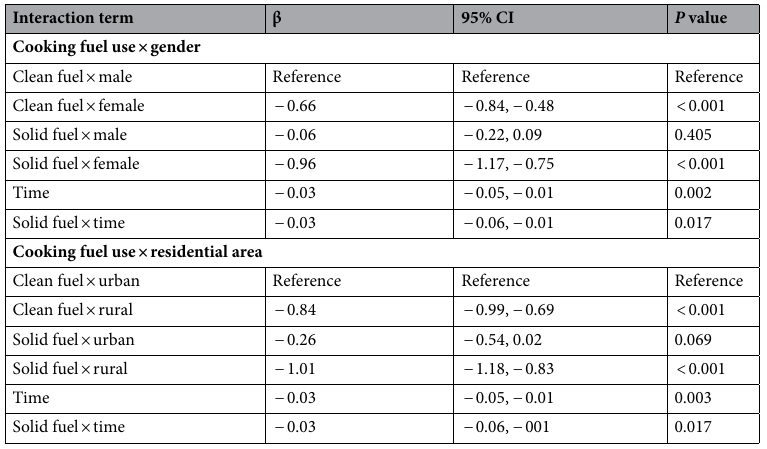
Table 3. The interaction between cooking fuel use and socio-demographic characteristics. In the linear mixed model of assessing the moderation effect of gender, we adjusted for cooking fuel use, time, cooking fuel use × time, age, residential area, marital status, education, smoking status, drinking status, sleep time, depressive symptom, chronic diseases and self-rated health. Besides, to analysis the moderation effect of residential area, we adjusted for cooking fuel use, time, cooking fuel use × time, age, gender, marital status, education, smoking status, drinking status, sleep time, depressive symptom, chronic diseases and self-rated health.